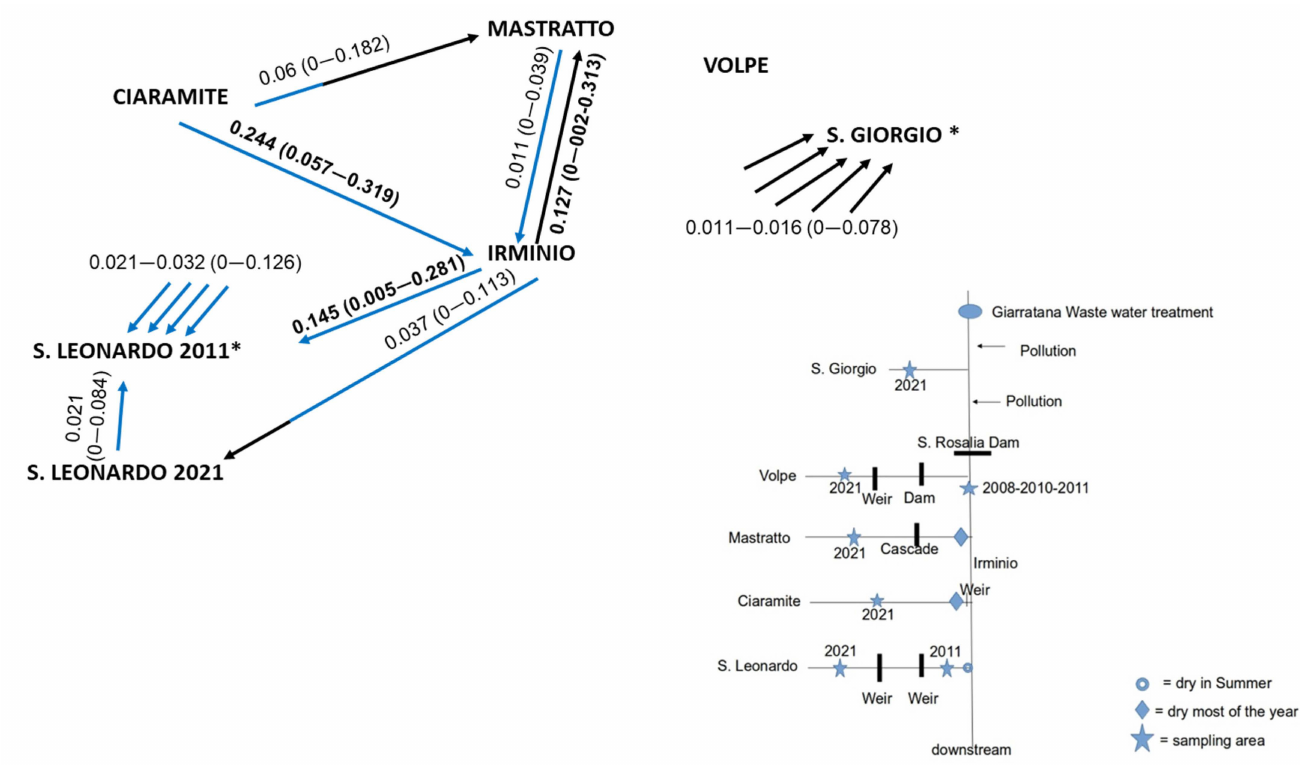
Figure 2. Gene flow direction and migration rate ( m ) estimates, with its standard deviation in parentheses. Blue and black: downstream and upstream direction, respectively. Only values of m > 0.01 are indicated, and m > 0.1 are highlighted in bold. * Estimates from/to these locations could be highly biased because of its reduced sample size, and m rates were summarized in these cases (note that a low migration rate to San Giorgio ( n = 13) comes from all but Volpe locations, whereas San Leonardo 2011 ( n = 6) receives migration from all the other locations). A scheme of the Irminio River basin and the putative barriers to gene flow is also